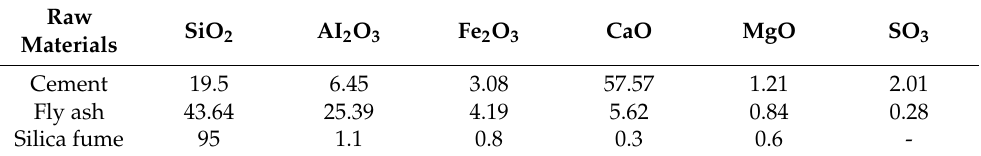
Table 2. Chemical compositions of cement and fly ash (unit: